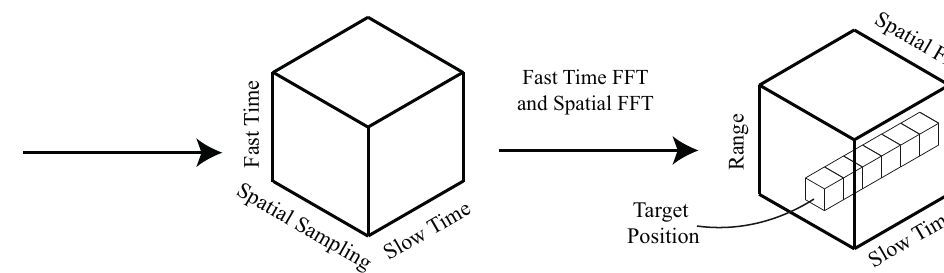
Figure 7. Radar signal processing